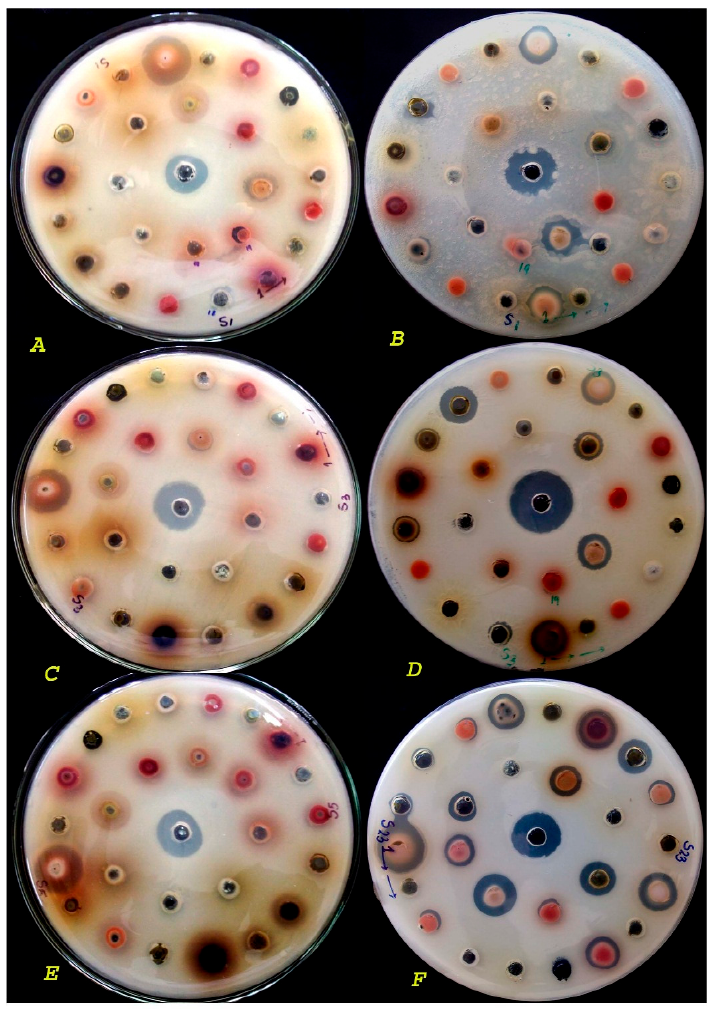
Figure 1. Screening of plant extracts; ( A ) Plant extracts (methanol) against E. coli ; ( B ) Plant extracts (water) against E. coli ; ( C ) Plant extracts (methanol) against S. aureus ; ( D ) Plant extracts (water) against S. aureus ; ( E ) Plant extracts (methanol) against S. typhimurium ; ( F ) Plant extracts (methanol) against V. cholera . Table 4. Minimum inhibitory concentration (MIC) results of selected plants from SBR. Plant